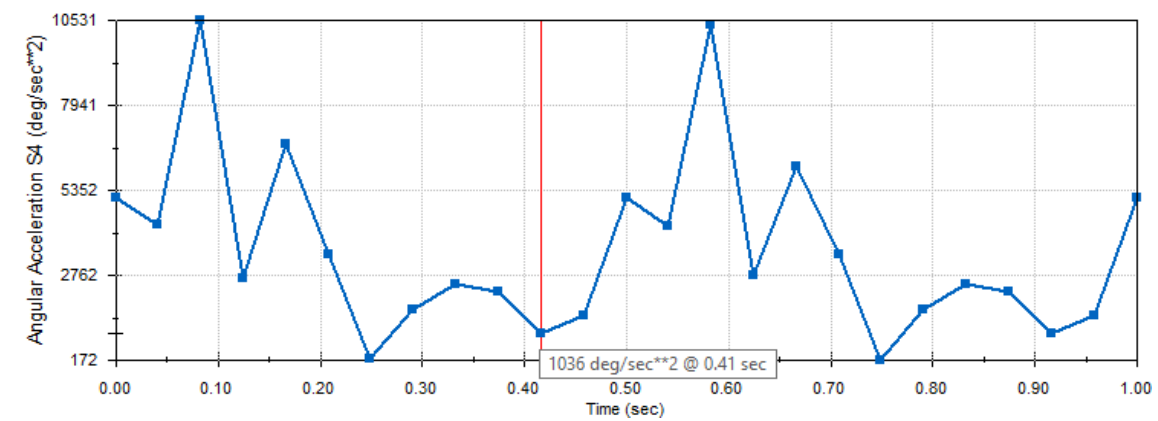
Figure 17. BC rod center of mass (S